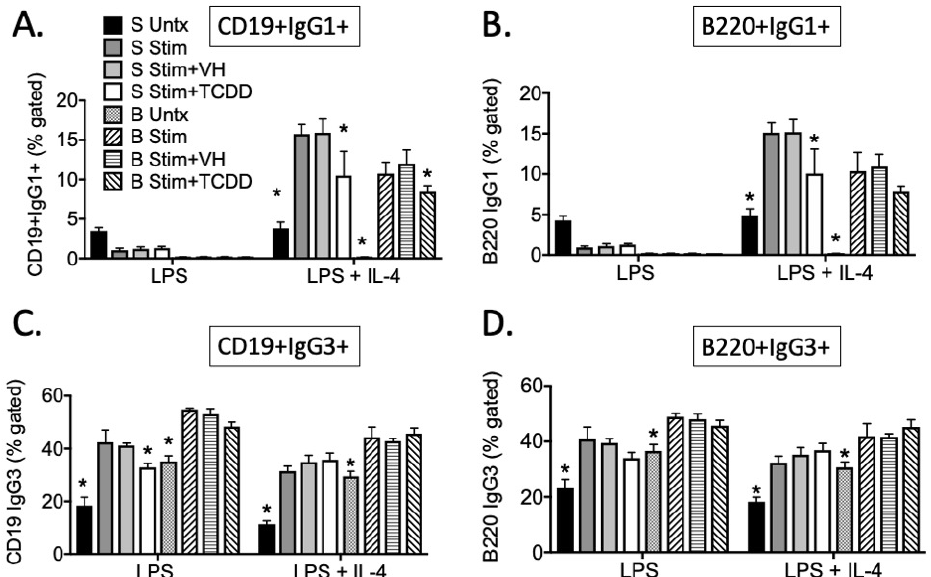
Figure 5. TCDD inhibited the percentage of CD19+IgG1+ cells. SPLC or B cells were treated with VH (0.01% DMSO) or TCDD (30 nM) for 30 min then were stimulated with LPS (5 µg/mL) alone or with IL-4 (10 ng/mL). Cells were incubated for 4 days then stained for CD19, B220, IgG1 and IgG3. Cells were gated on live single lymphocytes. ( A ) CD19+IgG1+; ( B ) B220+IgG1+; ( C ) CD19+IgG3+; ( D ) B220+IgG3+. Bars represent mean ± SD from triplicate samples. S, SPLC; B, B cells; Stim, LPS or LPS + IL-4; VH, vehicle; Untx, untreated. * p < 0.05 as compared to respective Stim + VH control within cell type. Experiments were repeated at least twice.